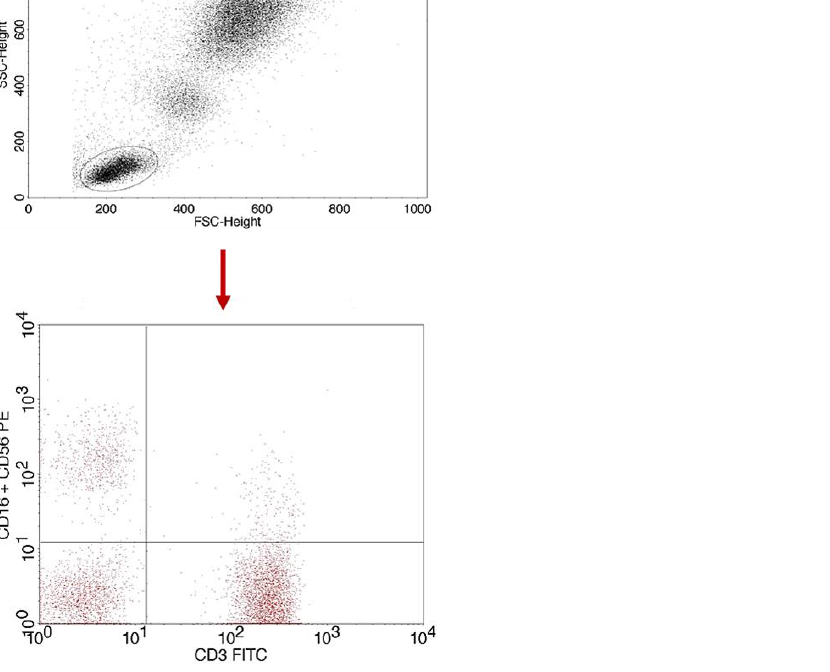
Figure 11. Sample analysis of the percentage of NK cells with the CD3-CD16+CD56 phenotype.